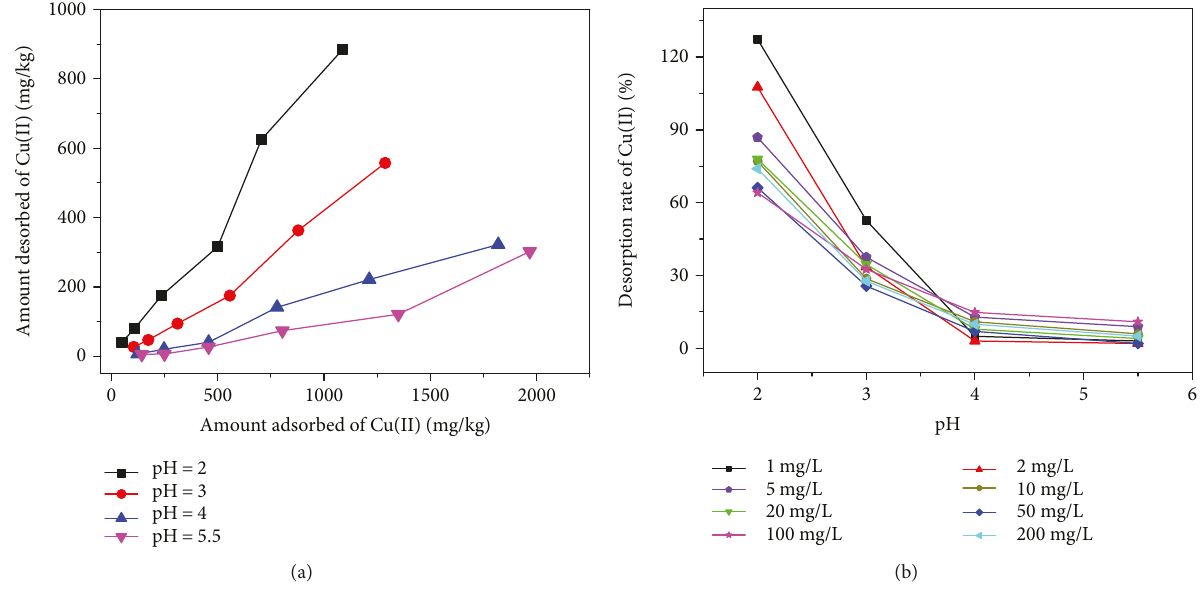
Figure 9: E ff ect of pH on desorption: (a) desorbed amount of Cu(II) and (b) desorption rate of